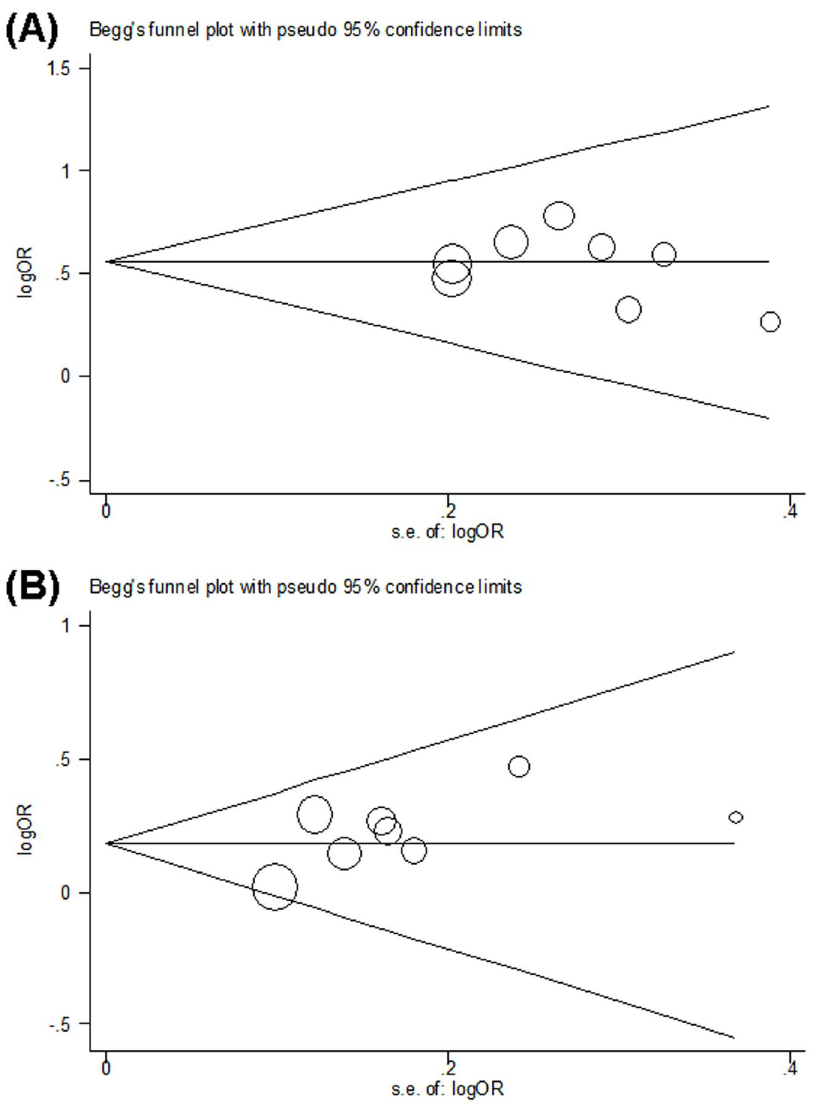
Figure 4. Begg’s funnel plots of Arg399Gln polymorphism and glioma risk for publication bias test. Each point represents a separate study for the indicated association. Log (OR), natural logarithm of OR. Horizontal line, mean effect size. (A) Gln/Gln vs. Arg/Arg. (B) Arg/Gln vs. Arg/ Arg.